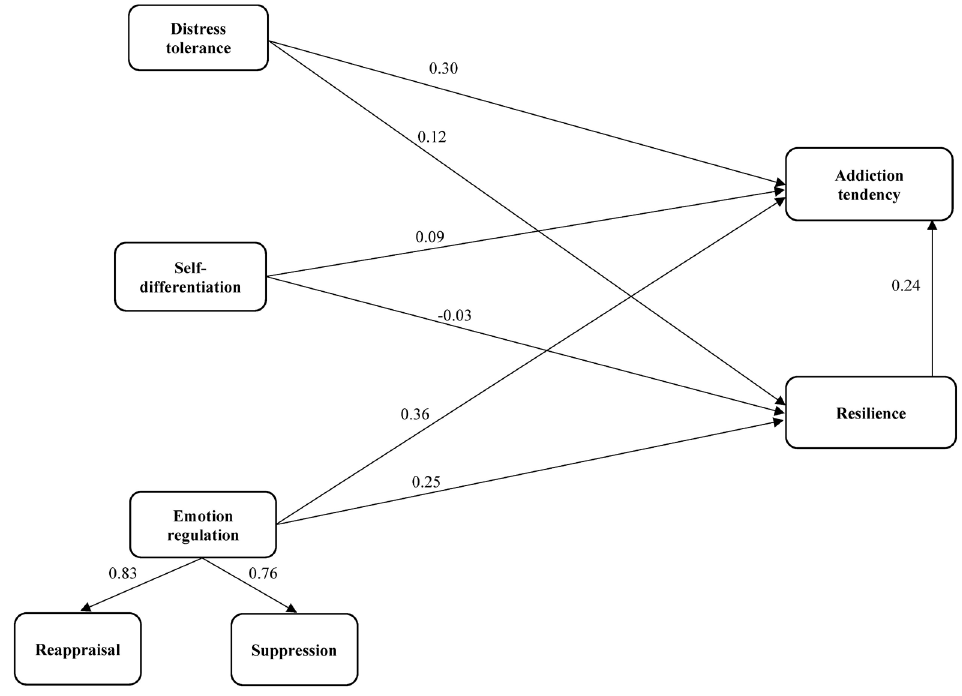
Figure 1. The proposed model in the standard coefficient estimation mode. Source . The results of the present